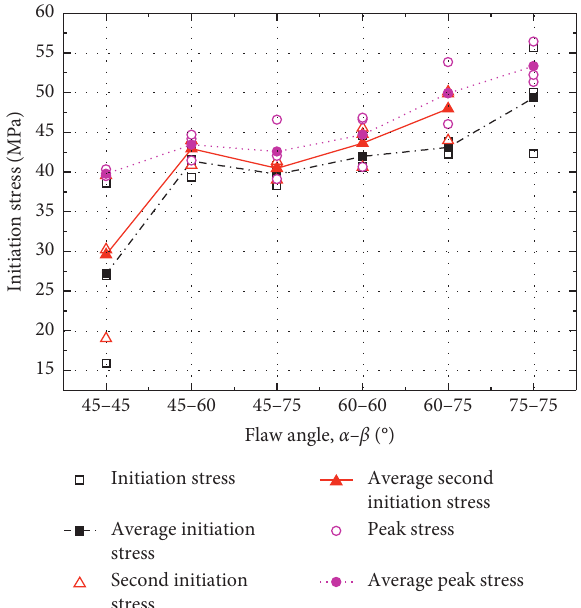
Figure 7: The crack initiation, second initiation, and peak stress versus flaw inclination angle in the specimens. Note . The lines pass through the average magnitude of the stresses for different flaw inclination